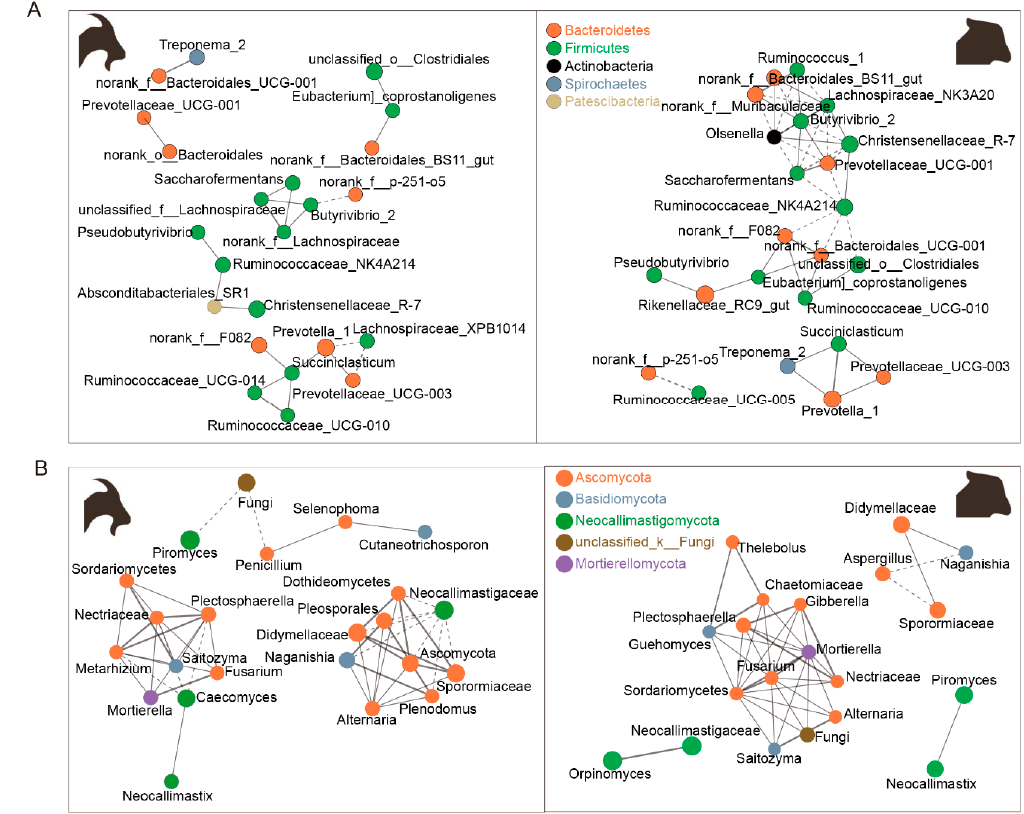
Figure 4. Network analysis of bacteria and fungi. Network analysis applied to microbiota in the rumen of goats and sheep. Genus correlation network maps mainly reflected the genus (relative abundance top 25)-relatedness under the same host. The correlation coefficient between genera reflected the correlation between genera. The size of the node was proportional to the abundance of the genera. Node color corresponded to phylum taxonomic classification. A solid or dotted line of the edge represented positive or negative correlations, respectively and the edge thickness was equivalent to the correlation value. ( A ) bacteria and ( B ) fungi.